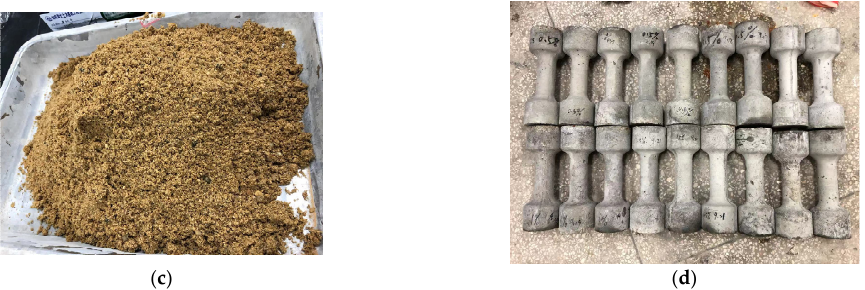
Figure 1. Material picture: ( a ) stone ( b ) steel fiber ( c ) sand ( d ) SFRC specimen.